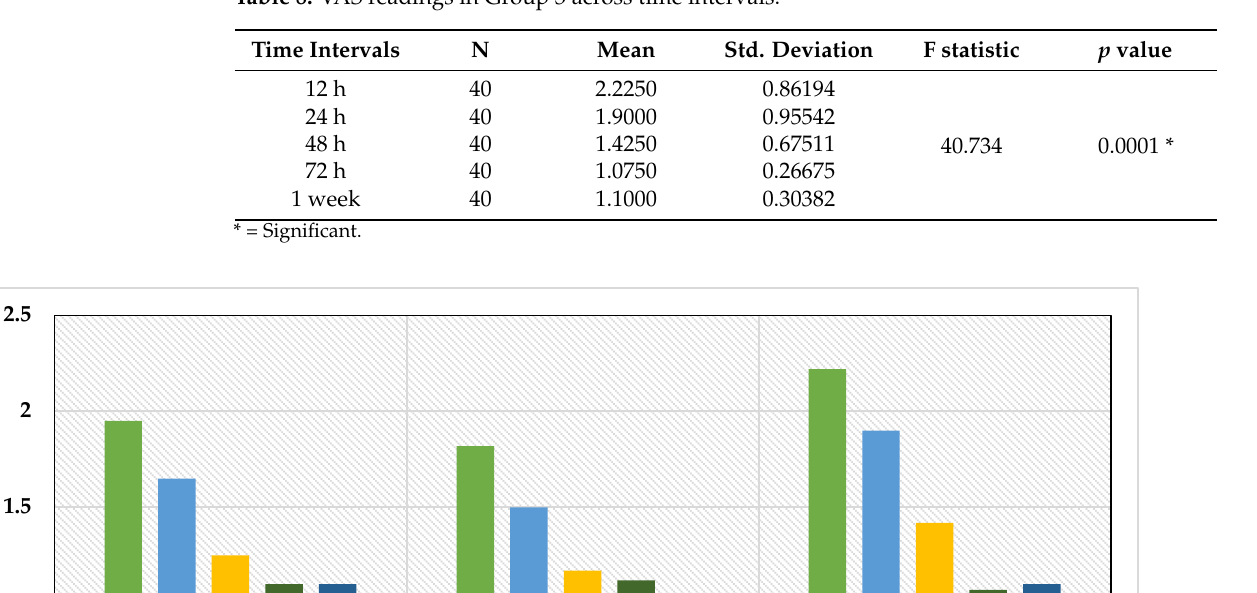
Table 8. VAS readings in Group 3 across time intervals.